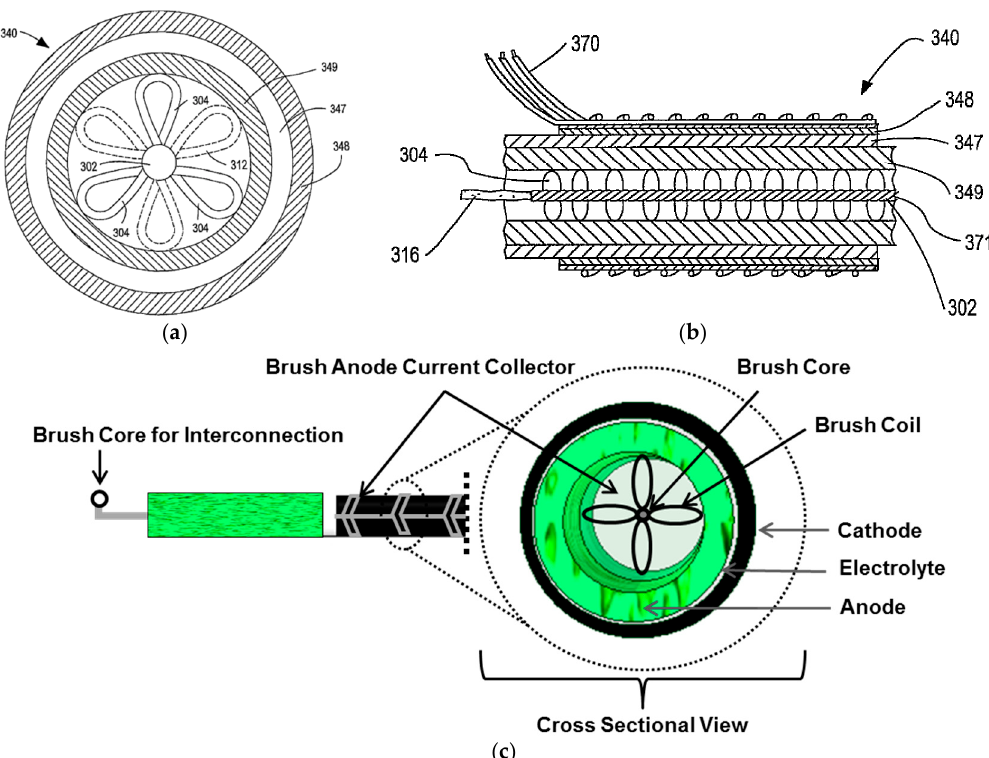
Figure 13. Brush current collector: ( a ) AMI design front view, ( b ) AMI design side view, and ( c ) schematic in a tubular cell with cross-sectional view adapted from AMI [129].